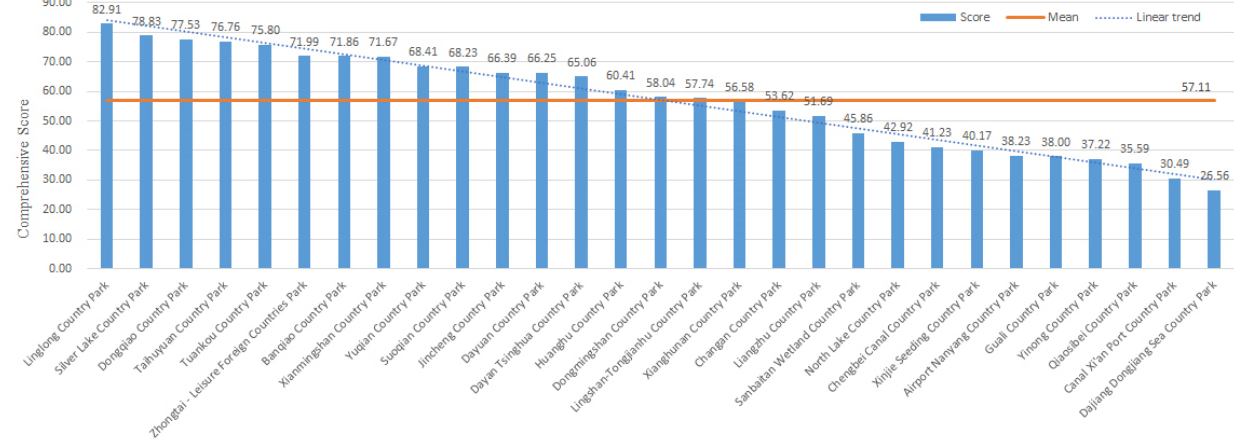
Figure 12. Comprehensive score of the country parks.